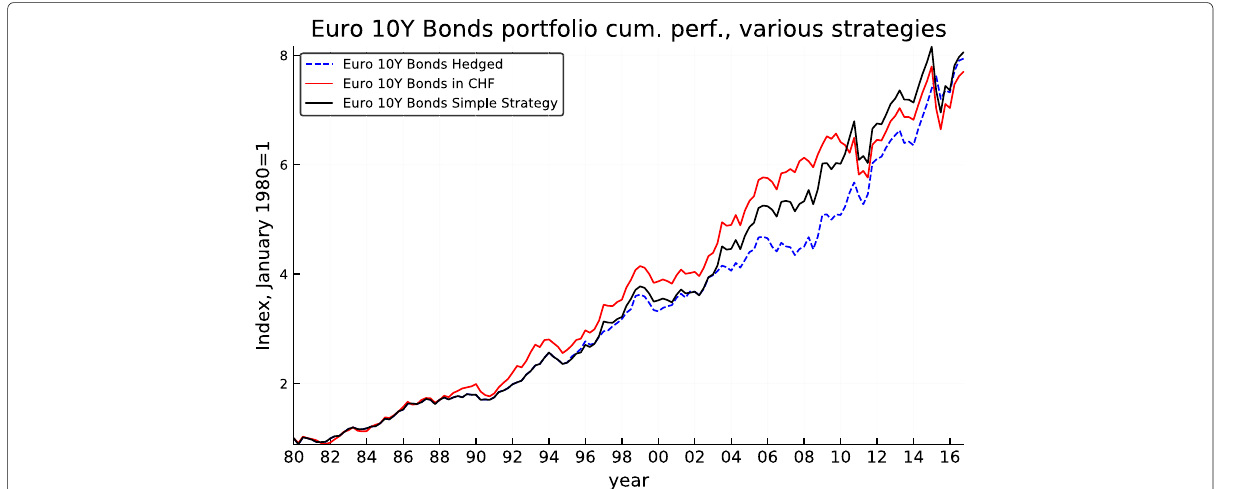
Fig. 5 Euro 10-year bond cumulative performance: unhedged, hedged, and simple strategy